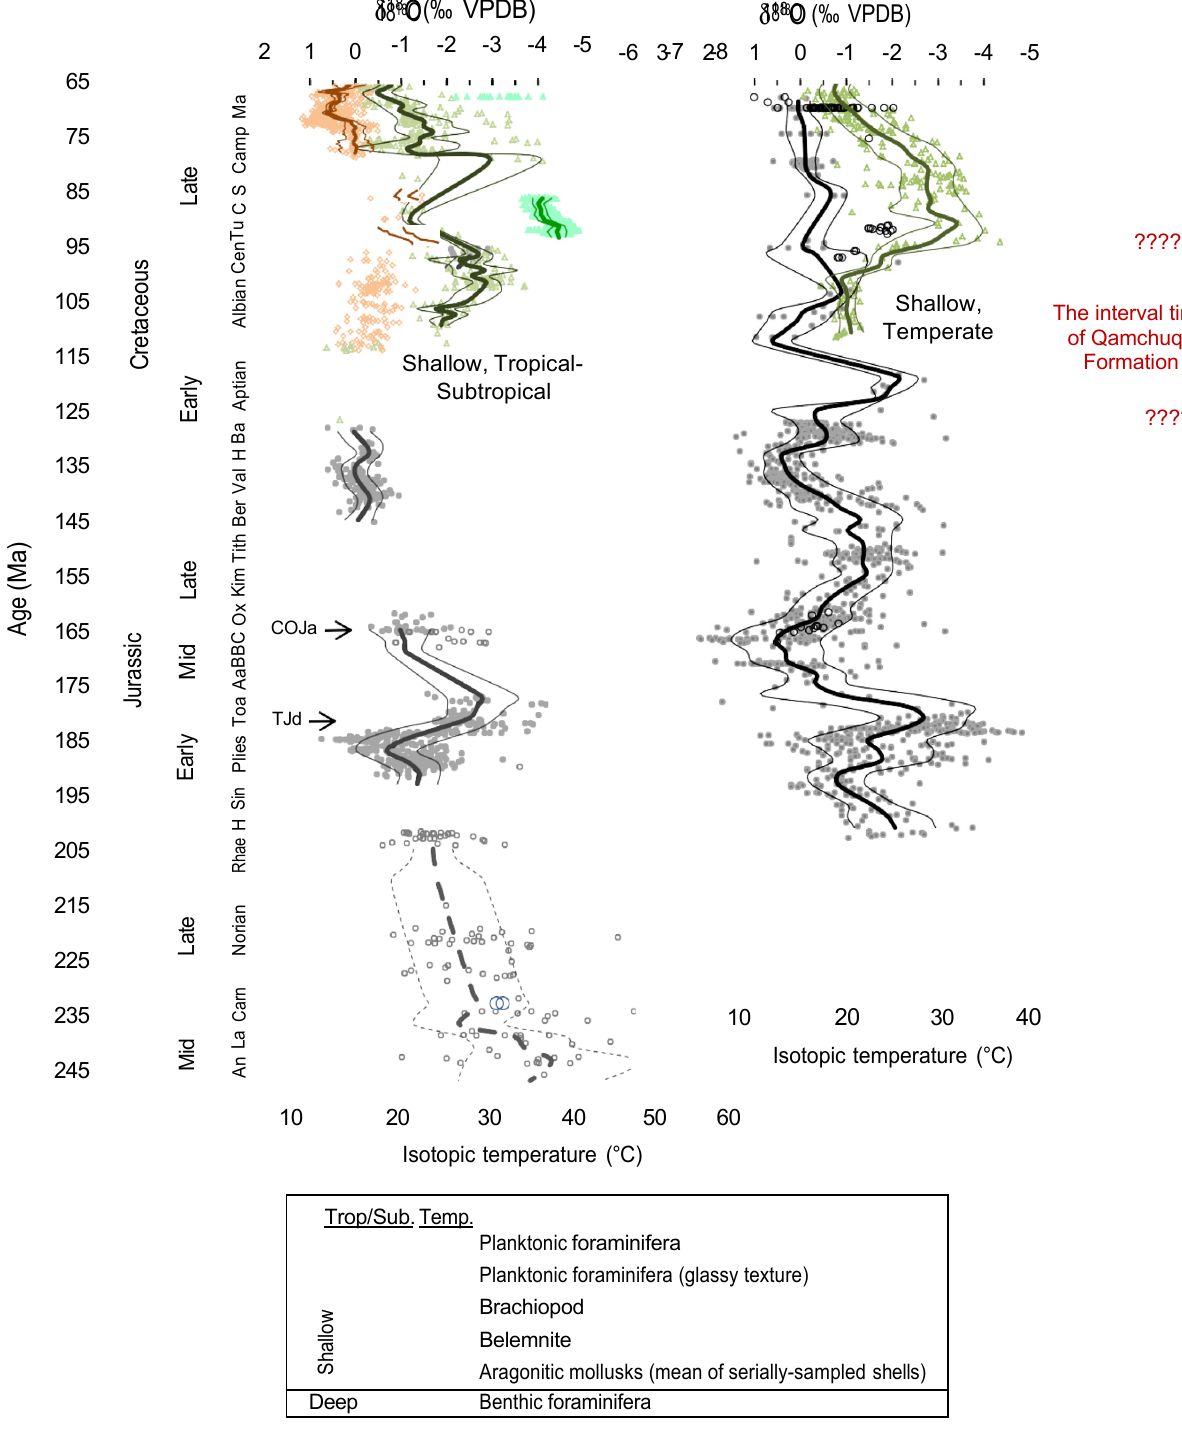
Figure 11. Oxygen isotope records for the Mesozoic, after [24]. The benthic foraminiferal data are obtained form [31].